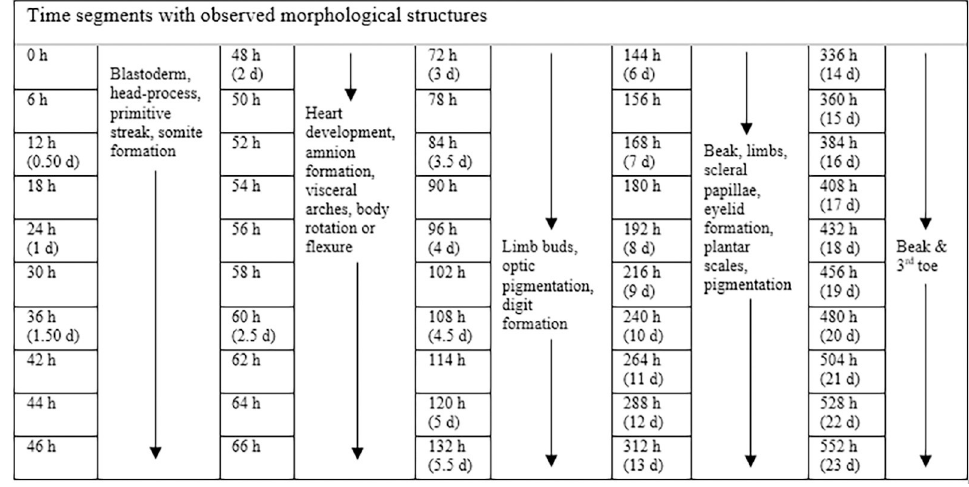
Fig 13. Time segments used for opening California valley quail eggs with observed key morphological structures for developing normal stages of